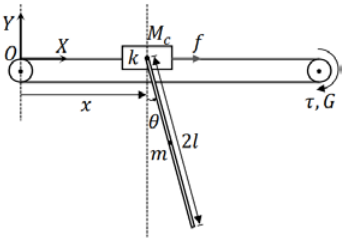
Fig. 1. Schematic diagram of the one-stage cart